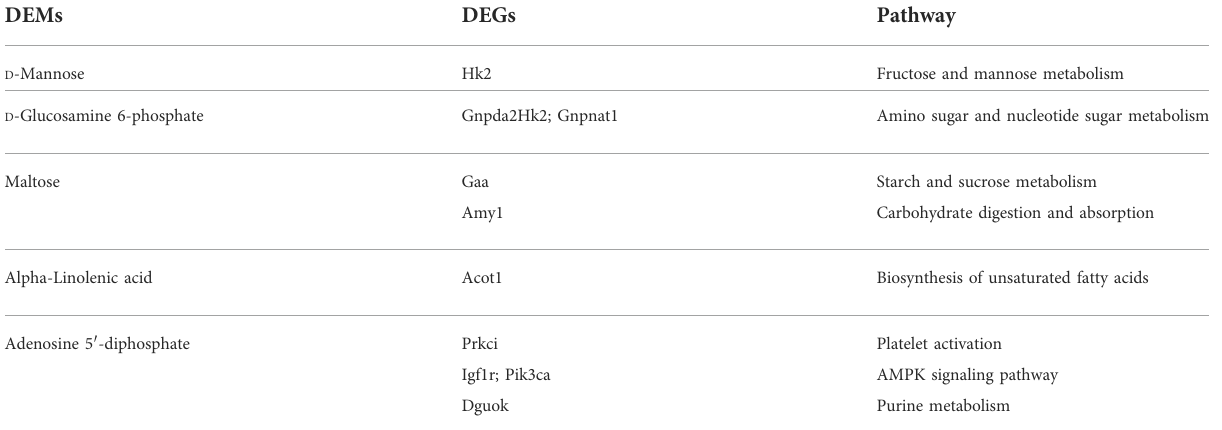
TABLE 1 Pathways of metabolites and related